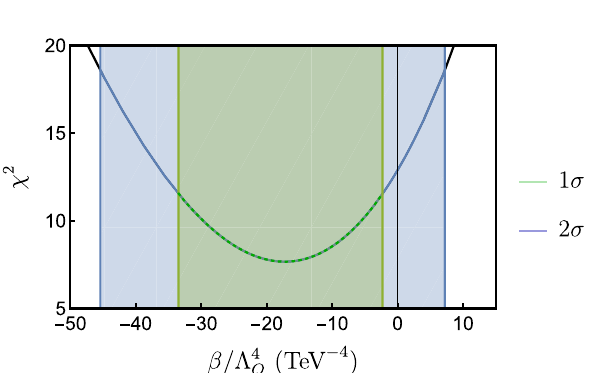
Fig. 1 Expected bounds on (cid:2) Q for different values of the ratio σ bound in logarithmic scale. Our bound is denoted by a red point